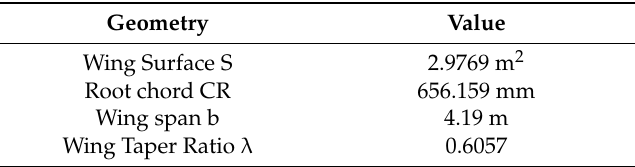
Table 5. Geometrical data of the